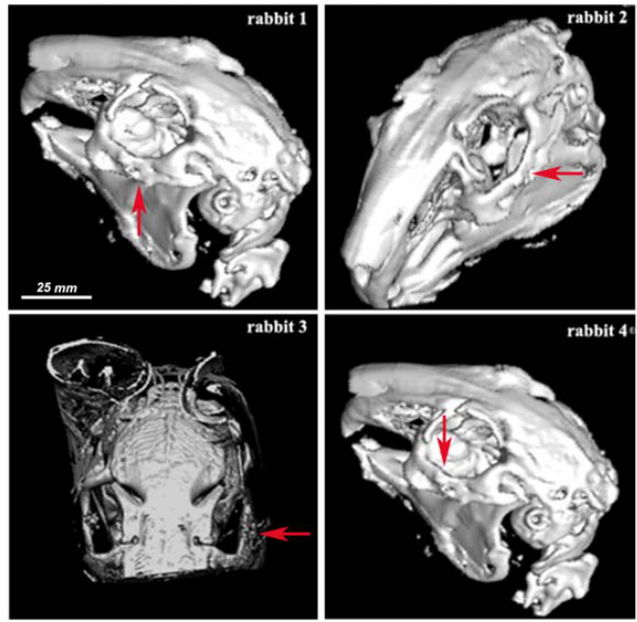
Figure 7. 3D CT osseous reconstruction images at two months postoperative for rabbits 1–4. Scale was estimated based on corresponding 2 ‐ D image.